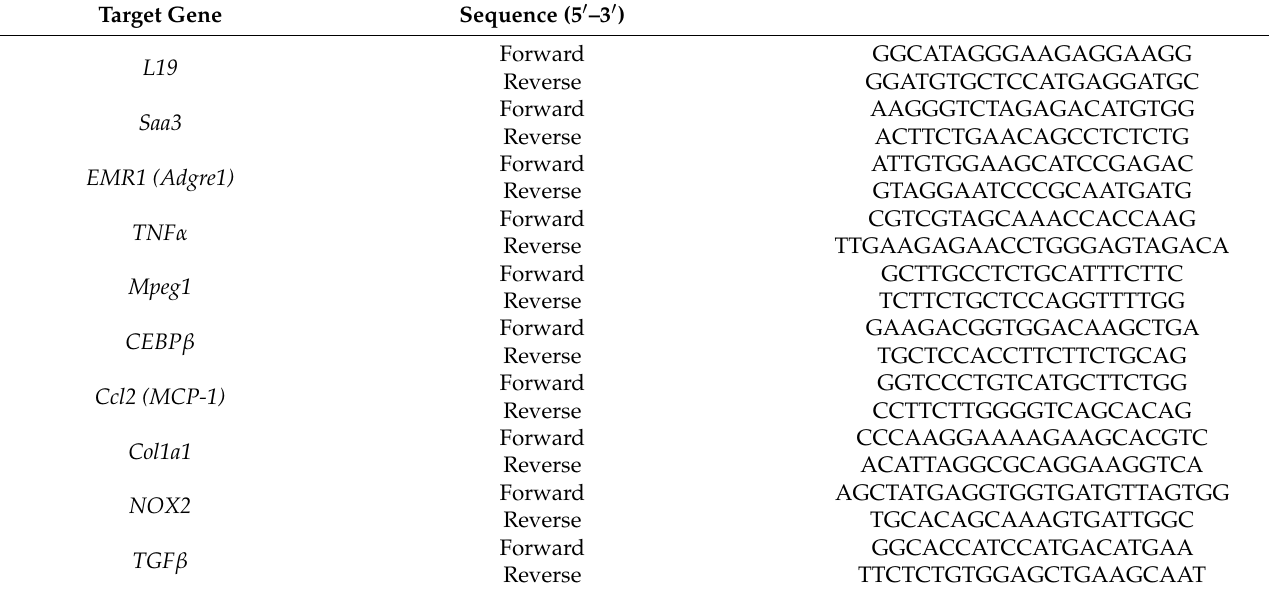
Table 2. Primer sequences for